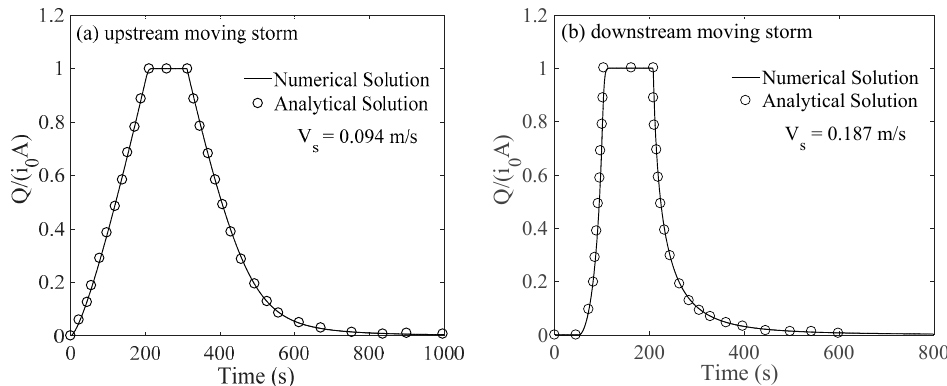
Figure 2. Comparisons of computed results and analytical solutions [34]. A : Basin area.